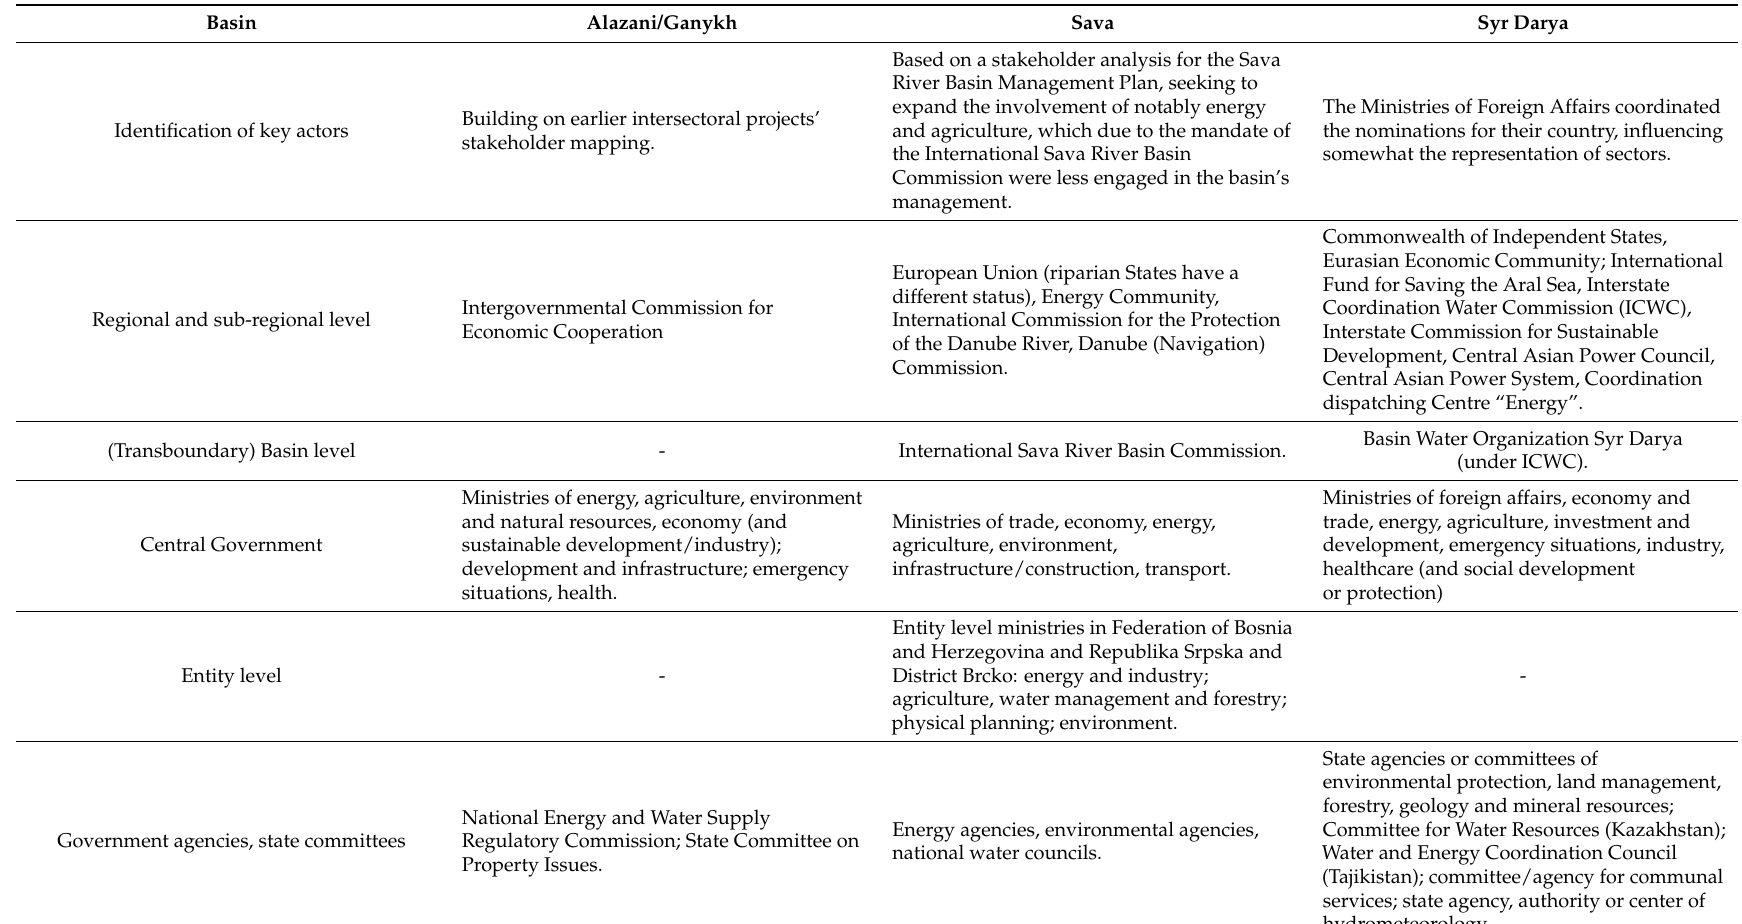
Table A2. Map ok Key Organizations and